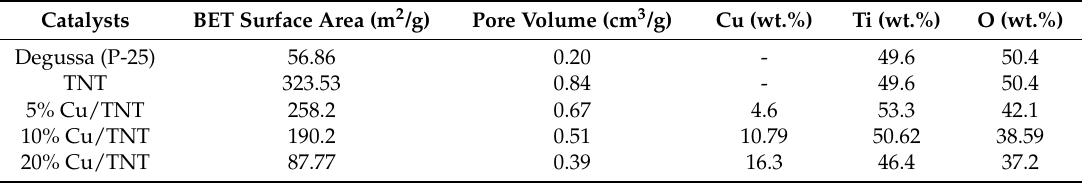
Figure 2. ( A , B ) SEM images of pure titanium oxides nanotubes (TNT) and for 20% Cu/TNT electrocatalysts ( C ) EDX spectrum for 20% Cu/TNT electrocatalysts. Table 1. BET surface area and chemical composition.